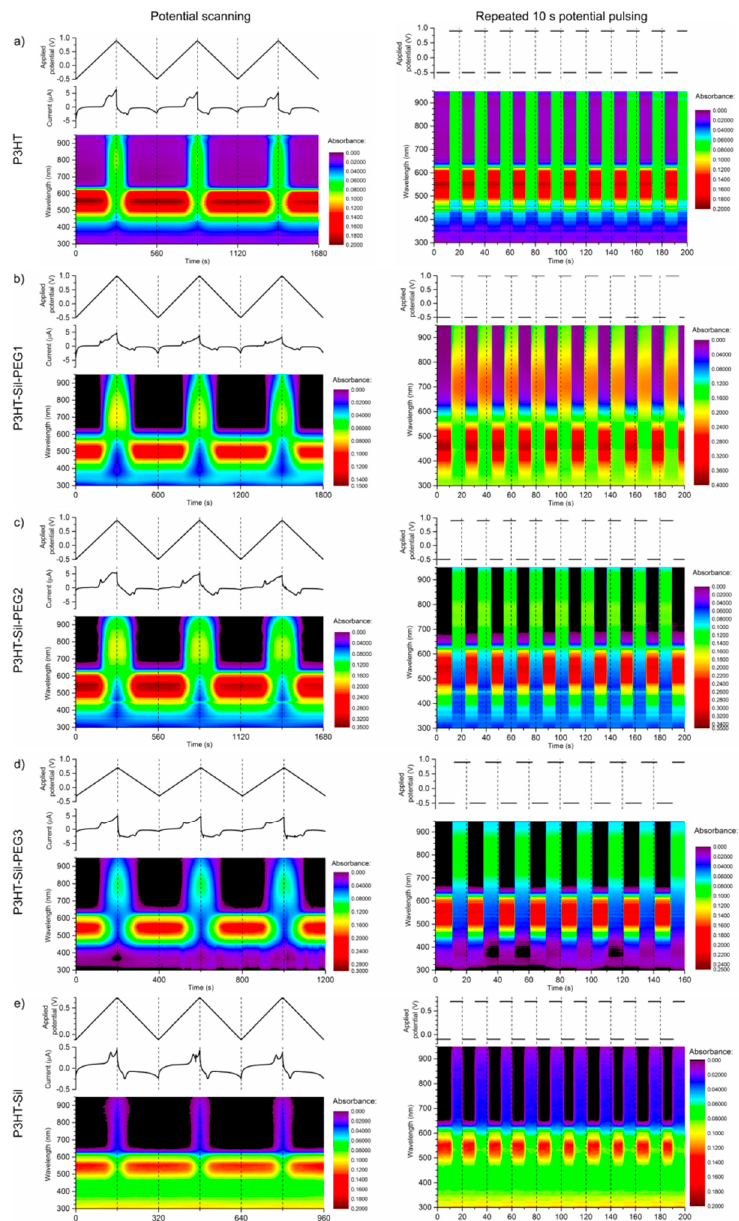
Figure 9 . Time-resolved UV-Vis spectra recorded during: potential scanning at a rate of 0.005 V·s − 1 (left) and repeated potential switching (right), with a 10s pulse duration of the investigated polymer and copolymer films: ( a ) regioregular P3HT; ( b ) P3HT-Sil-PEG1; ( c ) P3HT-Sil-PEG2; ( d ) P3HT-Sil-PEG3; ( e ) P3HT-Sil